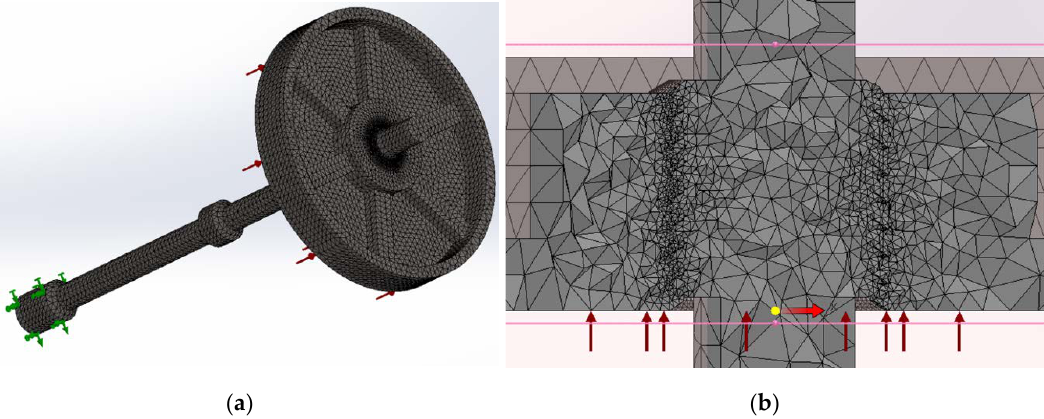
Figure 4. Solid model grid for the studied fuel system assembly: ( a ) complete discrete model, ( b ) within the studied thread-refinement.